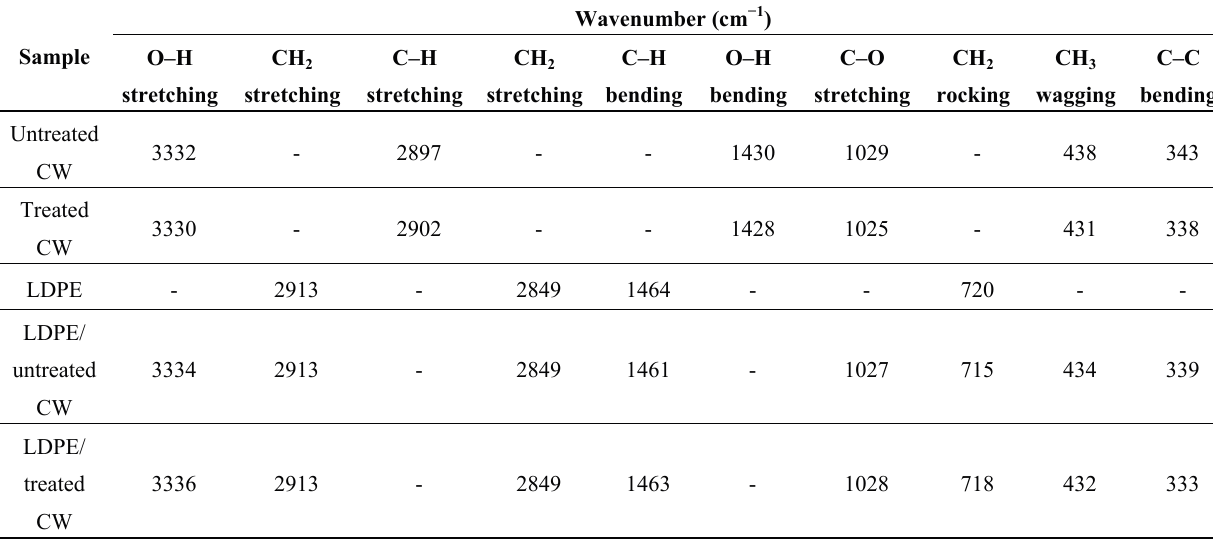
Table 1. FTIR bands of the untreated CW, treated CW, LDPE, LDPE/untreated CW and LDPE/treated CW